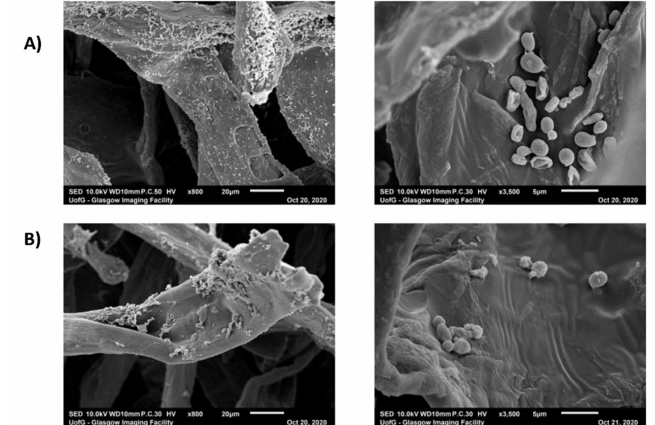
Figure 1. Scanning Electrion Micrograph of Candida auris grown on hydrogel cellulose matrix. C. auris grown for 48 h atop cellulose matrix in hydrogel system and incubated with ( A ) AMB-loaded CS beads and ( B ) CSP-loaded CS beads. Images were taken at 800 × and 3500 × magnification (left to right). Bars are provided for scale. Notable cell wall deformities are observable in treated